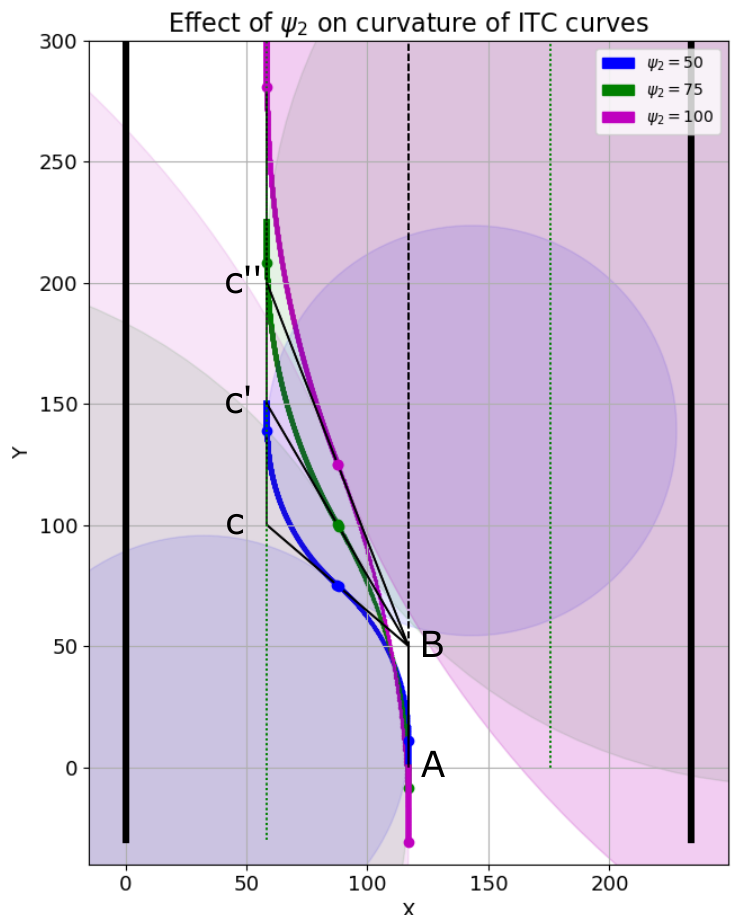
Figure 21. Effect of ψ 2 on ITC curve generation. Blue, green, and magenta curves were generated with ψ 2 = 50, ψ 2 = 75, and ψ 2 = 100, respectively.